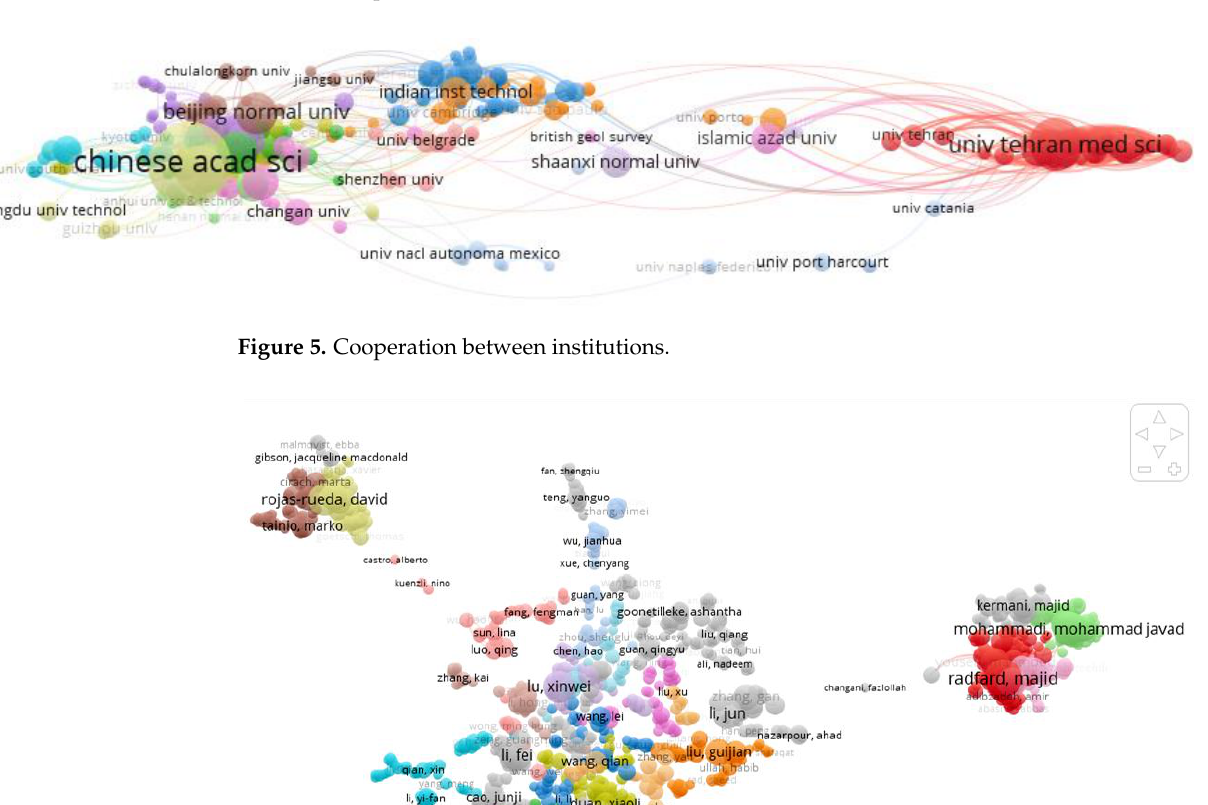
Table 2. Top 10 institutions with influence.